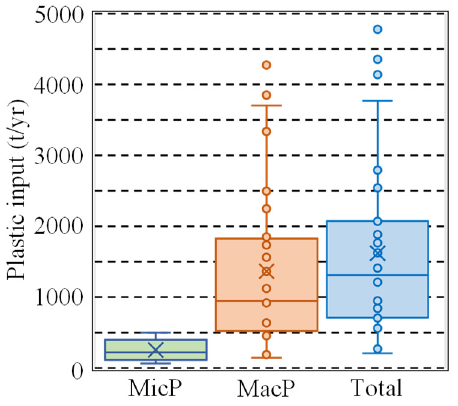
Figure 8. Box plots for annual inputs of MicP, MacP, and total plastics from the land to the sea in Japan.